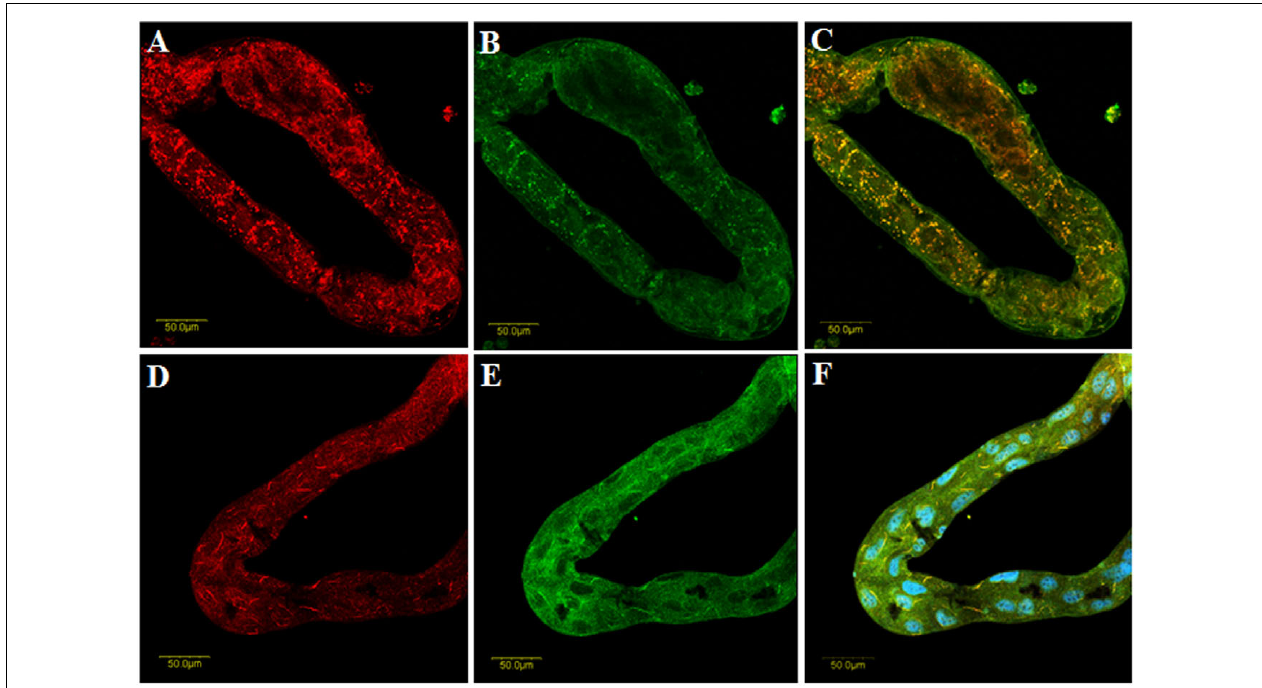
FIGURE 8 | Colocalization of TYLCV (A , red) and CypB ( B , green) in midguts dissected from VBt fed on 25% sucrose. (C) Shows the yellow spots where CypB and TYLCV co-localize. (D) Shows immunolocalization of TYLCV after feeding with the CypB inhibitor CsA and (E) Shows immunolocalization of CypB after feeding with the CsA inhibitor. (F) Is an overlay of (D and E) . Blue is DAPI staining of the nuclei.